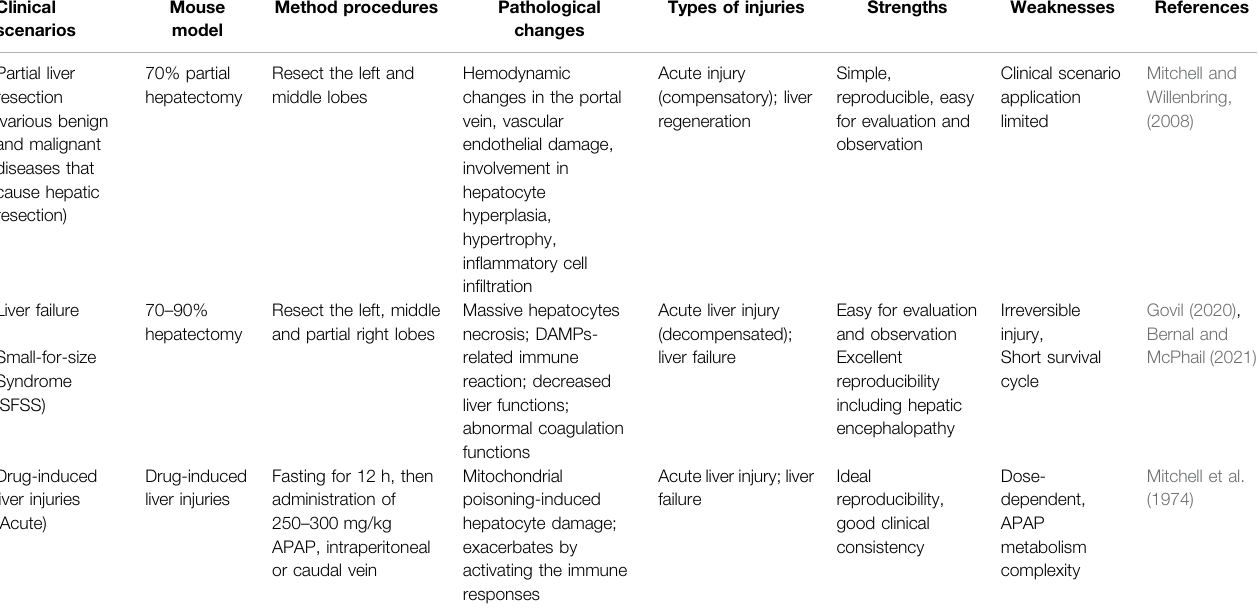
TABLE 1 | Mouse models of acute liver